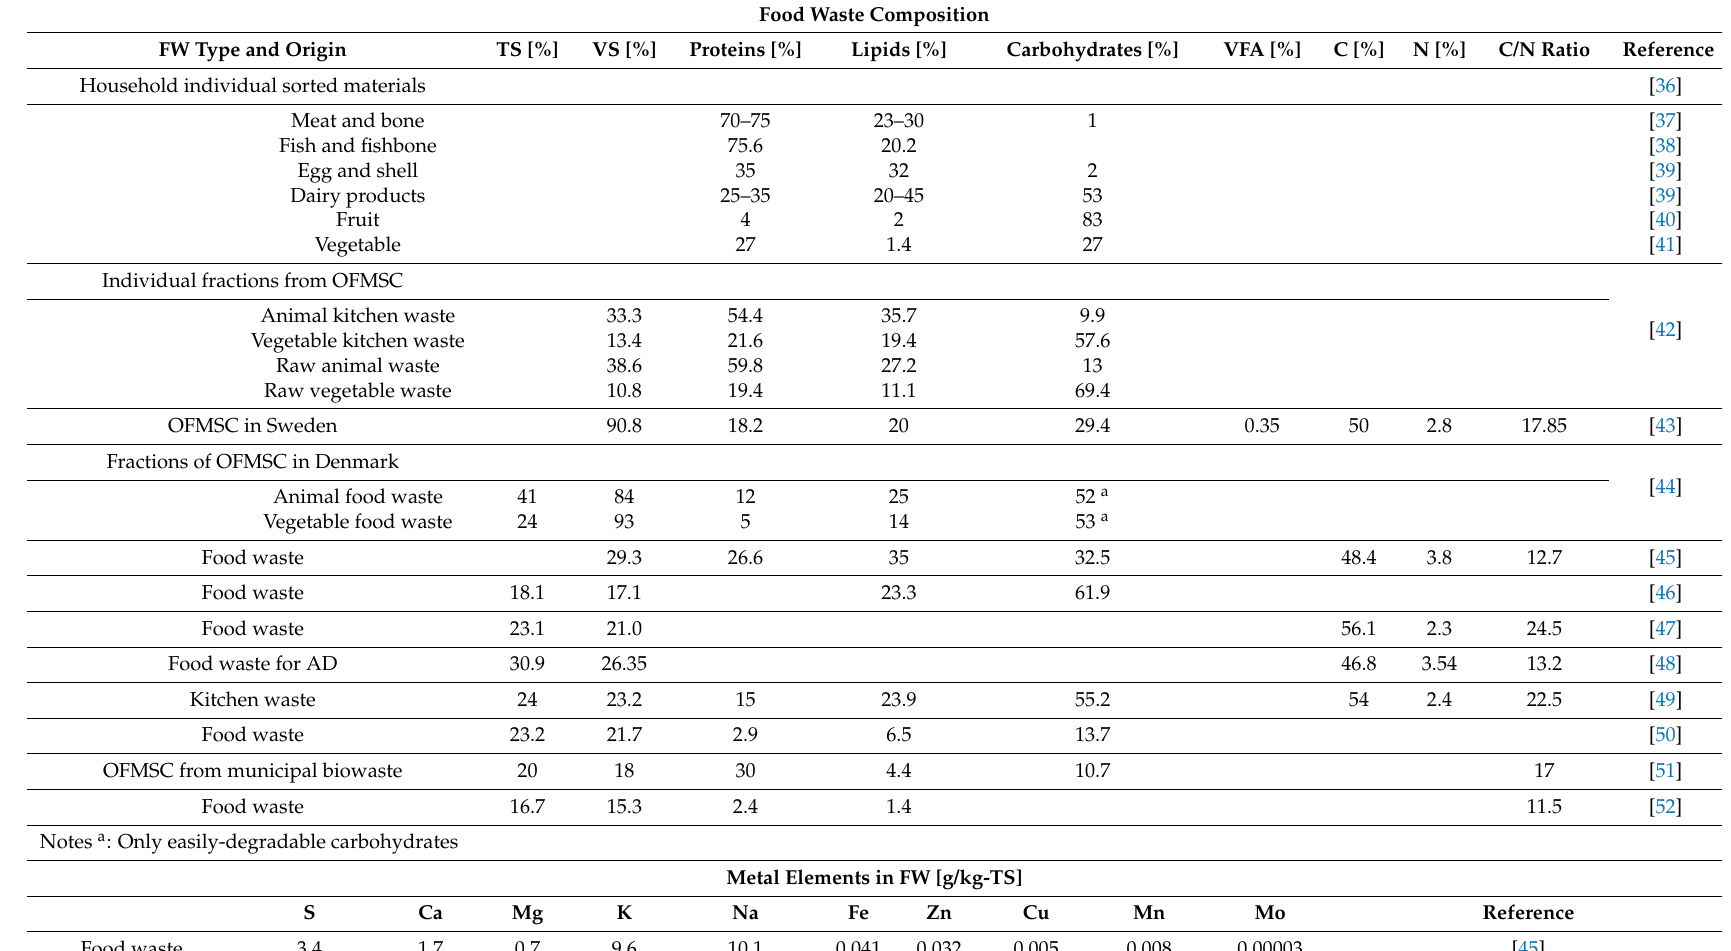
Table 1. Food waste composition reported by various